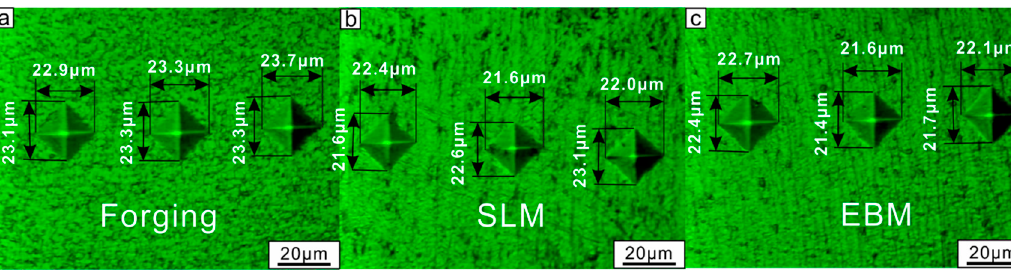
Figure 6. SEM micrographs of the samples after Vickers indentation: ( a ) forged, ( b ) SLM and ( c ) EBM.